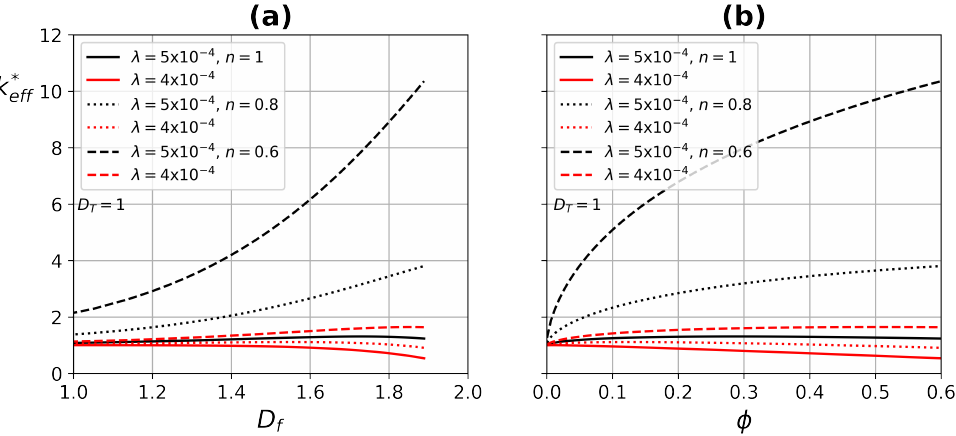
Figure 8. Effective thermal conductivity as a function of ( a ) fractal dimension D f , and ( b ) porosity φ . Continuous lines (Newtonian fluid) and dashed lines (non-Newtonian